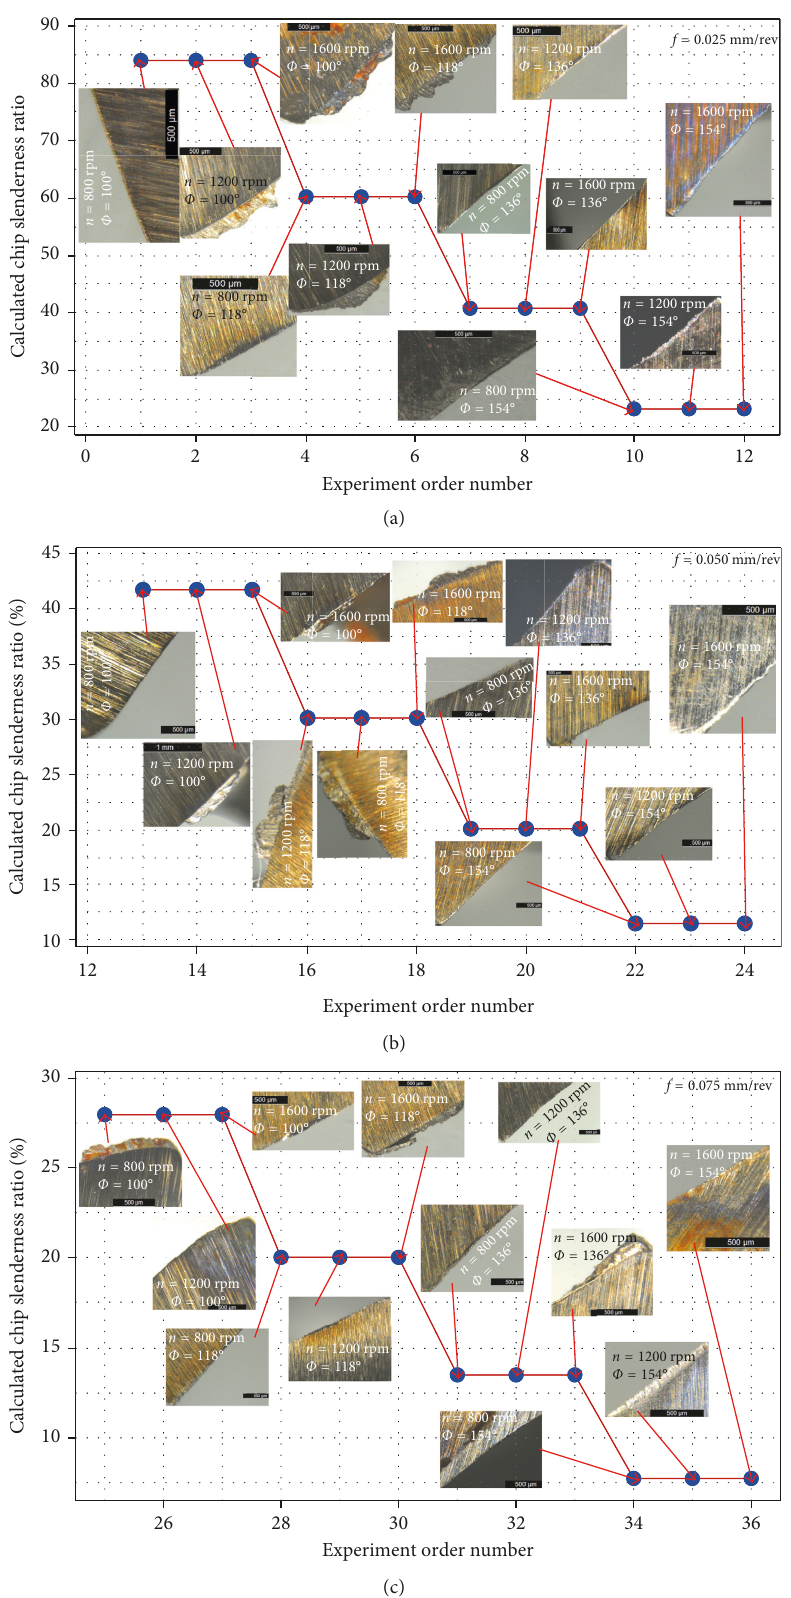
Figure 9: Effects of experimental and theoretical chip slenderness ratios on the tool wear. (a) 0.025mm/rev, (b) 0.050 mm/rev, and (c) 0.075mm/rev feed